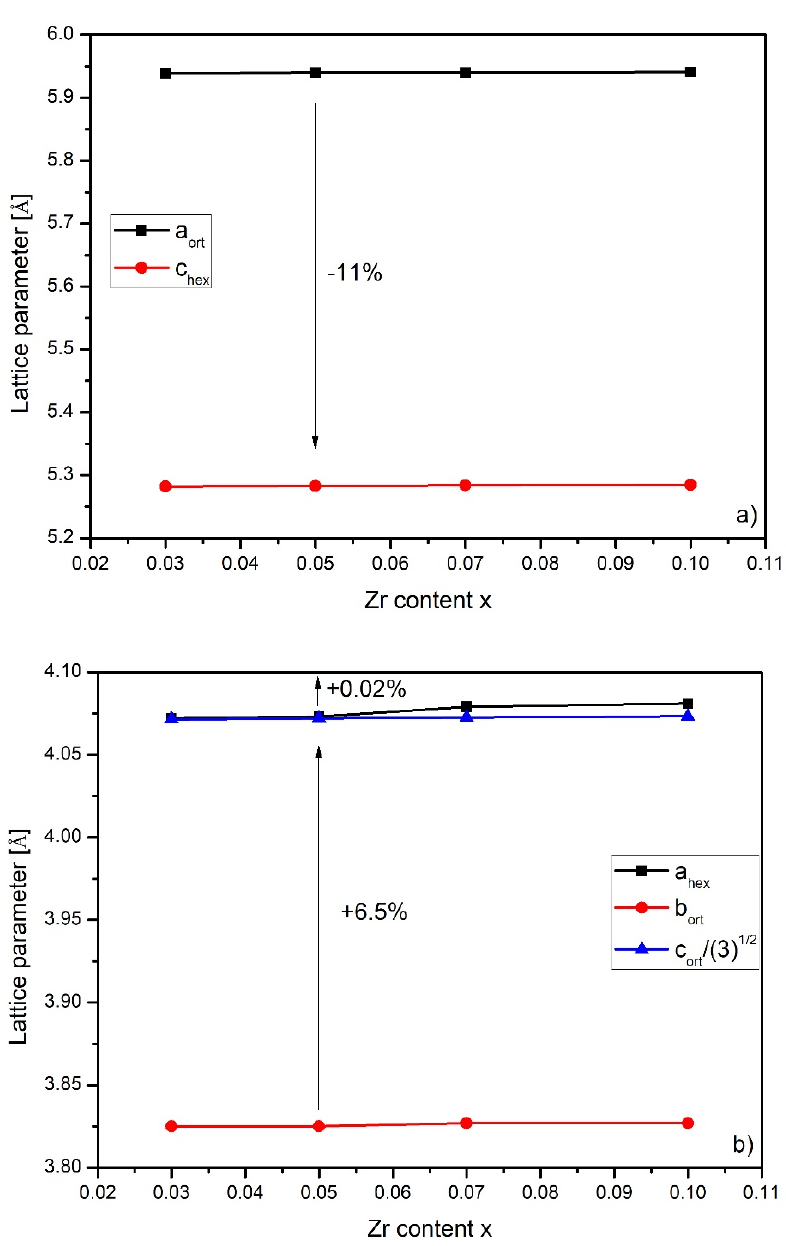
Figure 4. The Zr content dependence of the lattice constant of the analyzed unit cells. Errors were not matched as they were smaller than the symbol size. ( a ) Zr content of lattice parameters (a ort and c hex ); ( b ) Zr content of lattice parameters (a hex , b ort and c ort /(3) 1/2 )